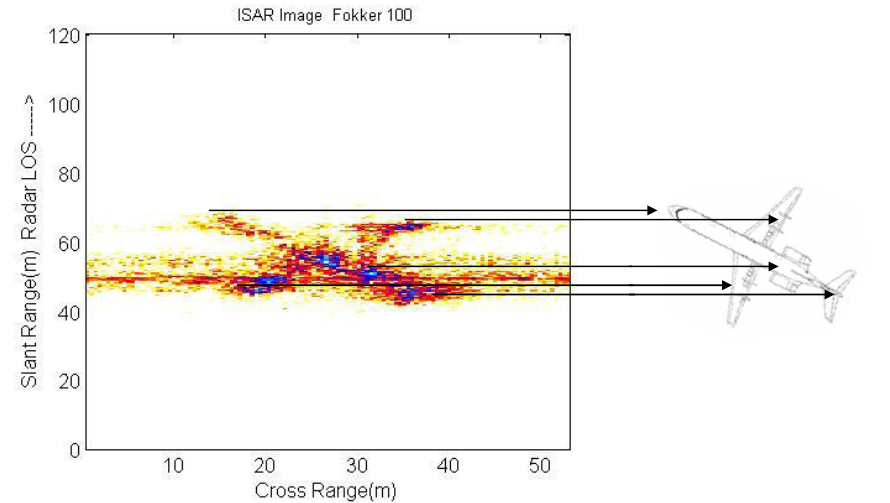
Figure 4. Scattering centers in an ISAR